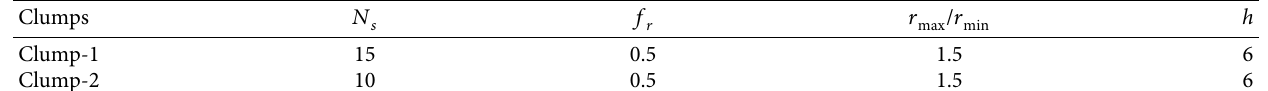
Figure 3: Representation of a polyhedral particle by a clump of spheres by the proposed algorithm: (a) the polyhedral particle; (b) Cluster-1; (c) Cluster-2. Table 1: Parameters of the algorithm to represent a polyhedral particle by a clump of spheres.